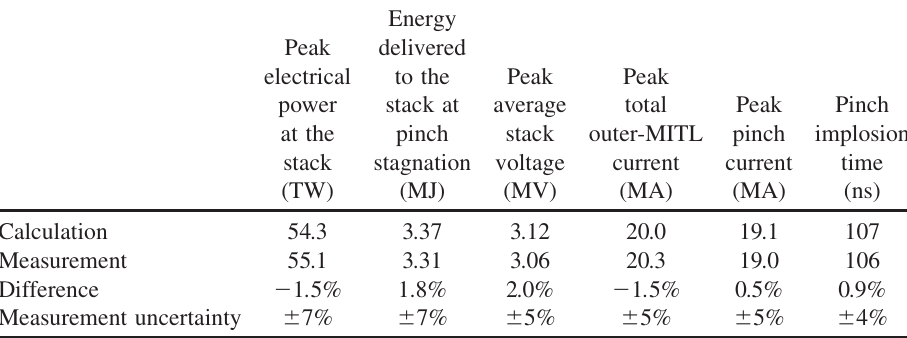
TABLE VII. Comparison of TL -model calculations with measurements taken on the Z accel- erator. (The calculations listed here are a subset of those given for MITL-design II in Table V.) The measurements are average values of data acquired on seven nominally identical Z shots. The load was a z pinch with a 2-cm length, 2-cm initial radius, and 4.27-mg total mass, which was the Z accelerator’s baseline load. The Marx-charge voltage on these shots was 90